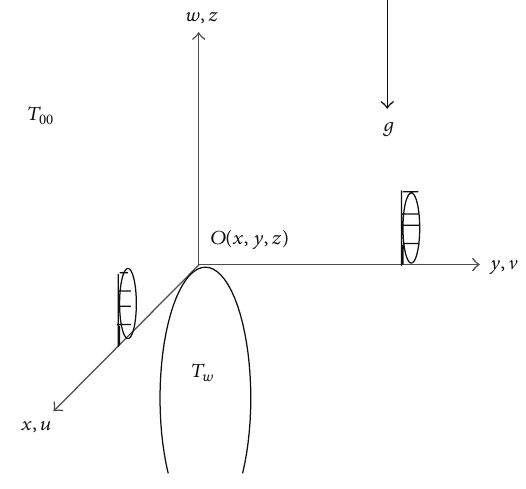
Figure 1: Physical